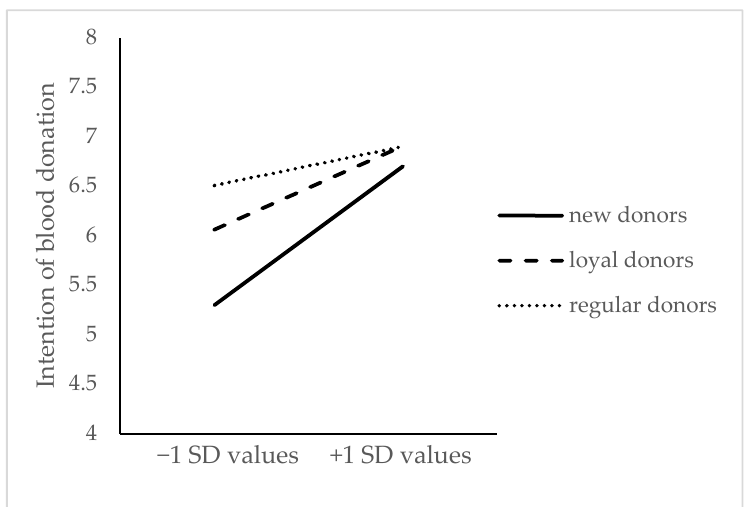
Figure 1. Intention to donate blood explained by moderation of understanding motivation and blood donor stage.